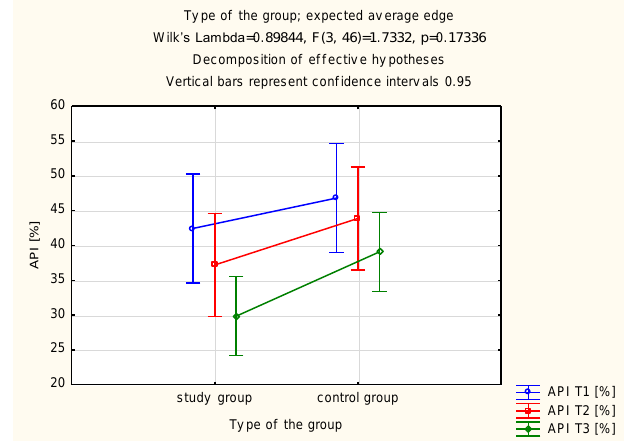
Figure 1. Estimated marginal means for the approximal plaque index (API) in the study and control groups.